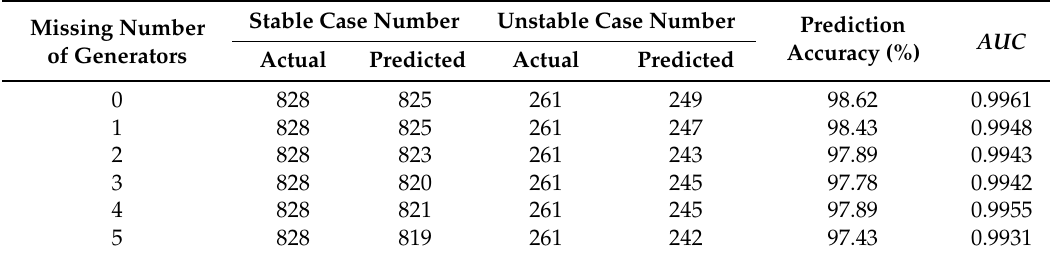
Table 7. Statistics of the prediction for incomplete WAMS